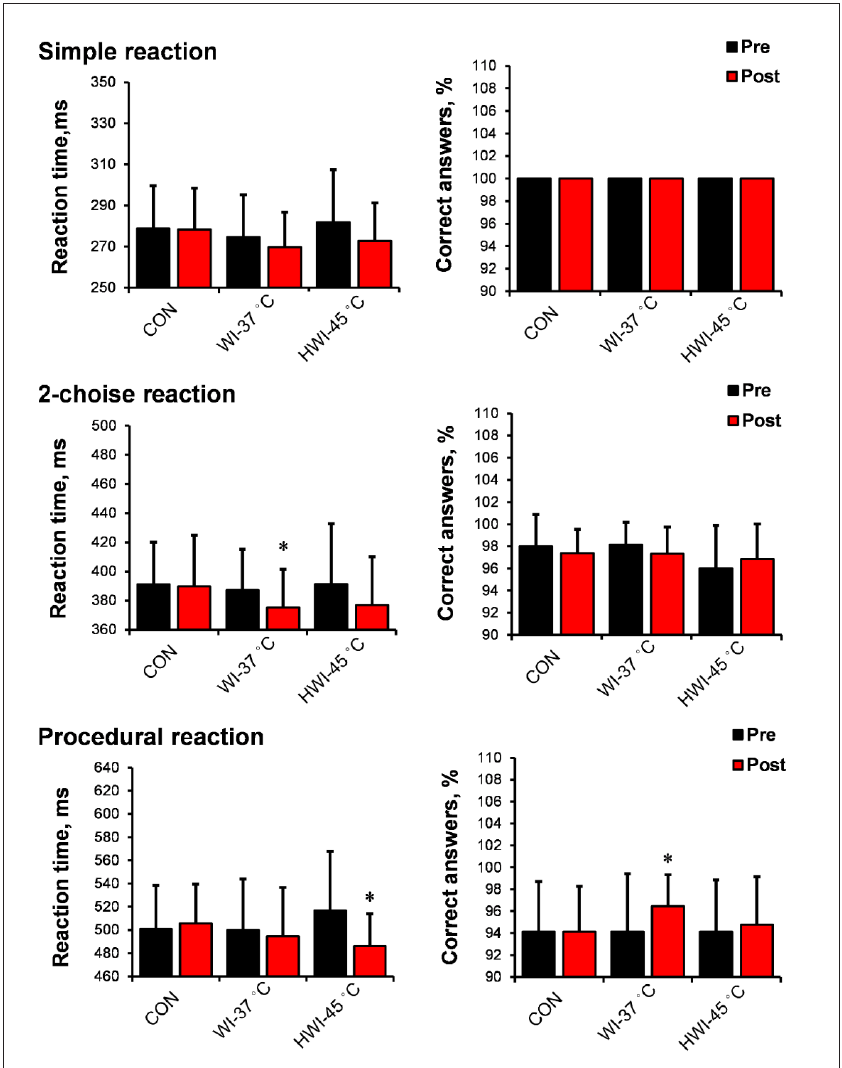
Figure 1. Changes in simple, 2-choice, and procedural reaction times, and percentage of